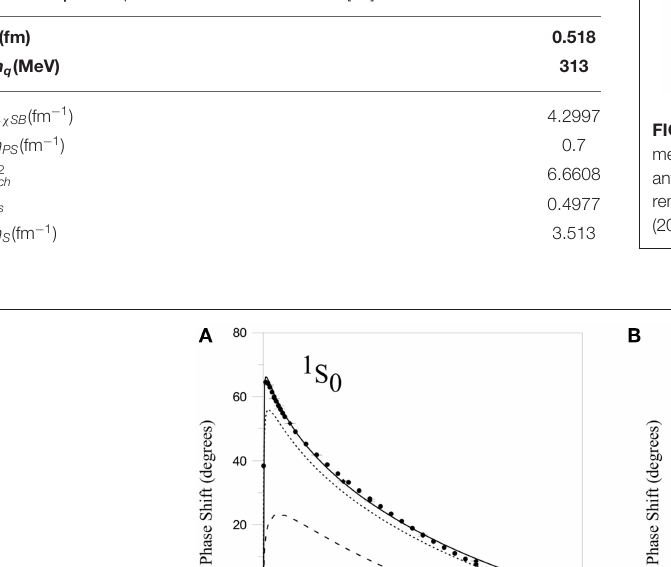
TABLE 1 | Model parameters from Entem et al. [52].